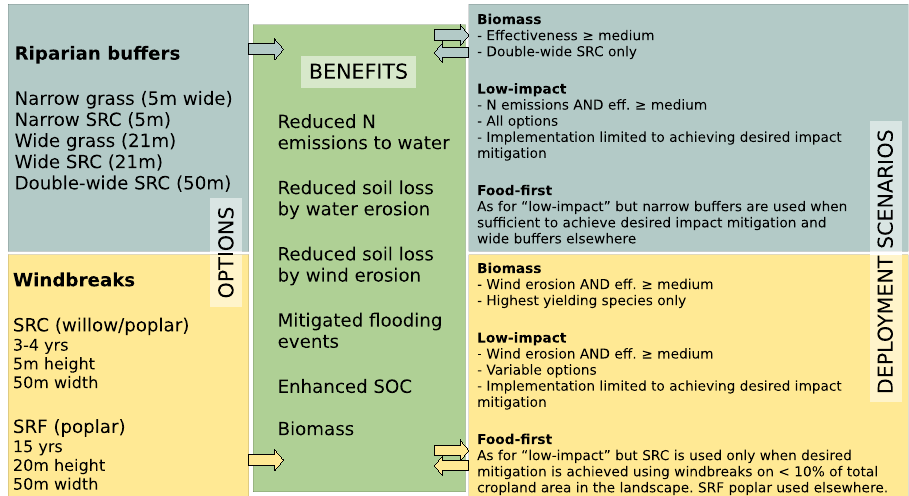
Fig. 9 Simpli fi ed illustration of options, bene fi ts, and scenarios included in the model. Riparian buffers have fi ve design options and aim primarily at reducing N emissions to water. Windbreaks have two design options and aim primarily at reducing soil loss by wind erosion. The model quanti fi es buffer/ windbreak areas, corresponding biomass output, and respective primary environmental bene fi t. Simultaneous mitigation of multiple other negative environmental impacts (co-bene fi ts) are also quanti fi